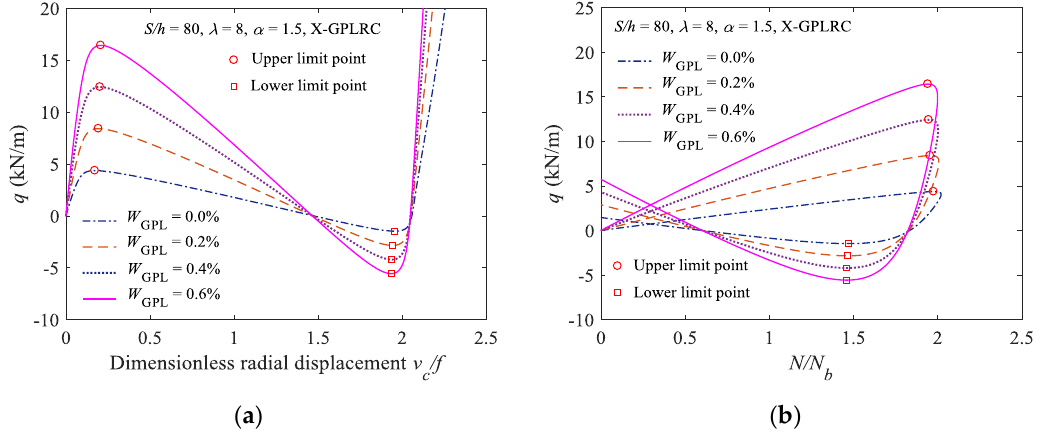
Figure 4. Effect of the GPLs weight fraction on the limit point buckling load: ( a ) Load displacement curve; and; ( b ) load-axial force curve.